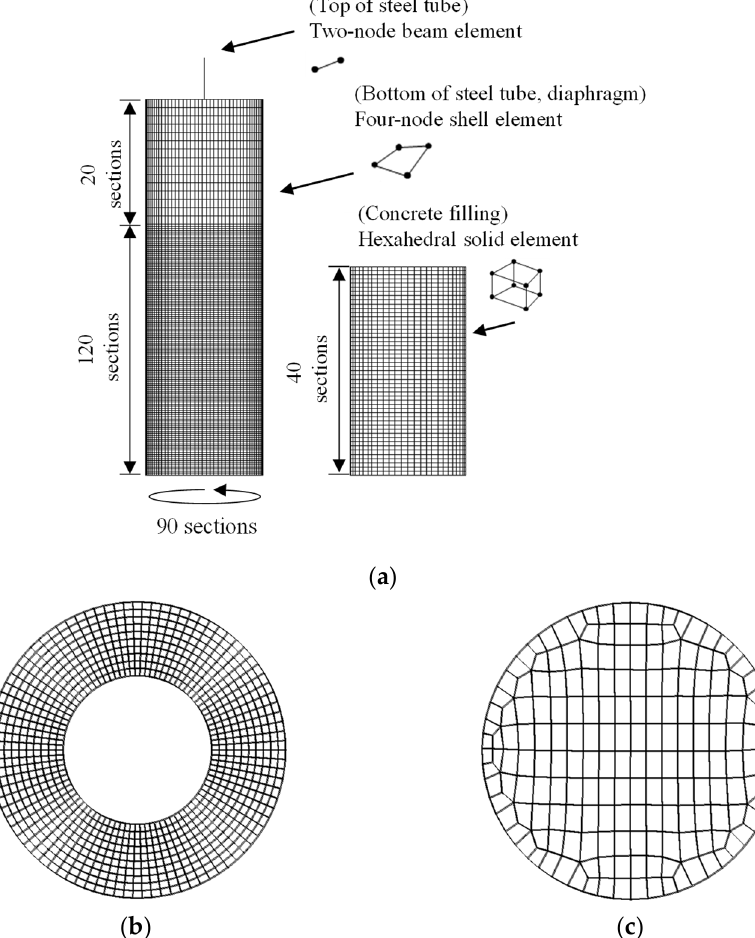
Figure 4. Sectioning of elements in the numerical model: ( a ) Steel tube and concrete; ( b ) Diaphragm; ( c ) Concrete section.